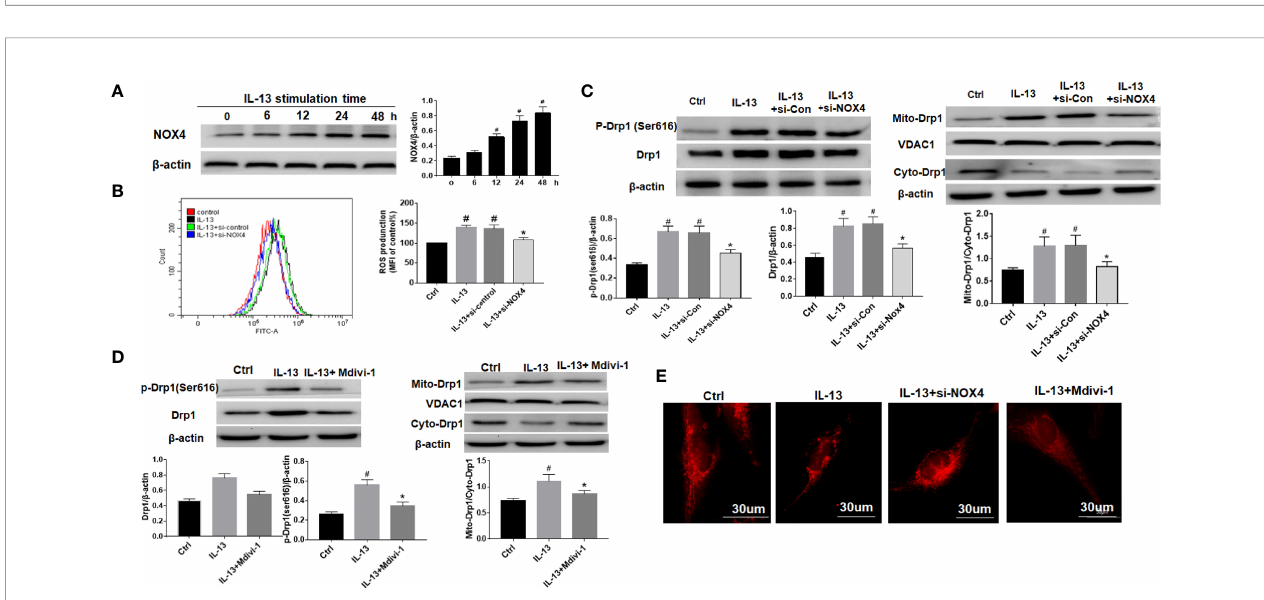
FIGURE 2 | NOX4 induces airway epithelial in fl ammation by triggeringmitochondrialdamage via regulation of ROS/Drp1. (A) Westernblot of NOX4 expression after IL-13 stimulation; (B) ROS expression was measured by fl ow cytometry, andNOX4siRNA intervention was performed before IL-13 stimulation ofBEAS-2B cells; (C) Western blot of Drp1and p-Drp1(Ser616) expression. (D) Westernblot of Drp1and p-Drp1(Ser616)expression.Drp1Inhibitor (Mdivi-1) intervention was conducted before IL-13 stimulation of BEAS-2B cells; (E) Mitochondrial morphological changes were observed byMtioTracker Red staining. Scalebar:30 µm. Alldatawere shown as mean ± SD (n = 3). # p < 0.05 versus control, * p < 0.05 versusIL-13 group as determinedby one-way analysisof variance (ANOVA)and Dunnett ’ s post hoc